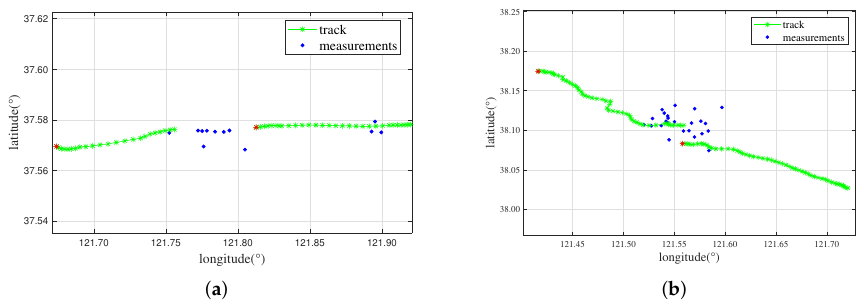
Figure 7. Tracklets illustration. ( a ) Tracklets of target 1. ( b ) Tracklets of target 2. (1) Missed